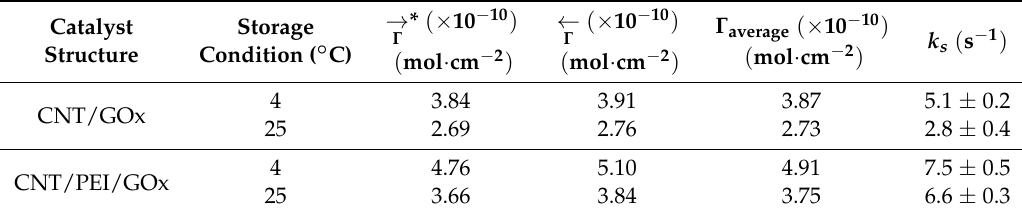
Table 2. Surface coverage activity and electron transfer rate constants of CNT/GOx and CNT/PEI/GOx at